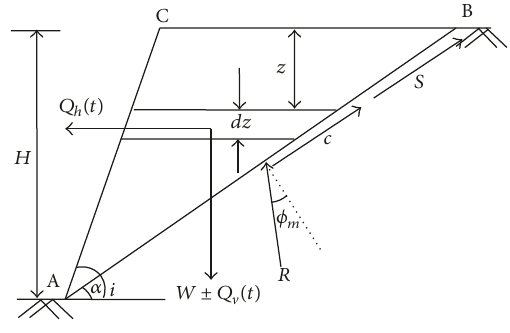
Figure 6: Forces on soil